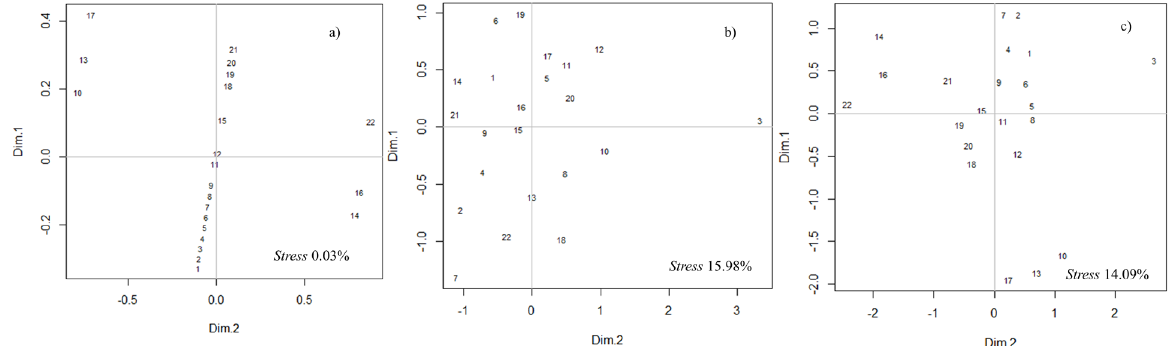
Figure 1. Graphic dispersion of 22 African mahogany ( Khaya senegalensis ) progenies by non-metric multidimensional scaling based on a) qualitative, b) quantitative and c) mixed data. Dim: